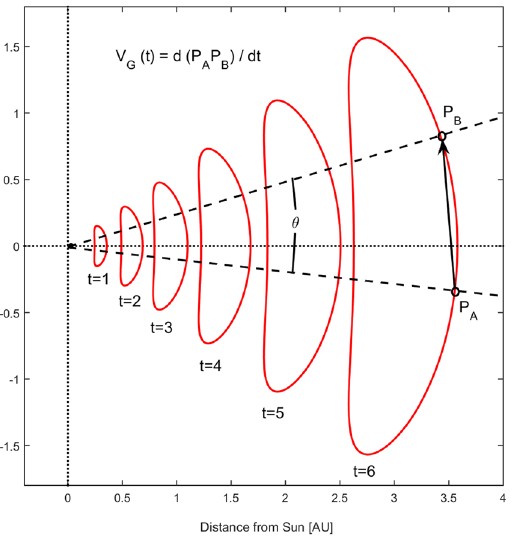
Figure 1. An analytical model for the cross-sectional area of a CME as it propagates anti-sunward. Snapshots are shown at successive times. The plane is perpendicular direction of propagation (e.g., the ecliptic or RN planes in heliocentric radial-tangential-normal, RTN, coordinates). Points P A and P B on the leading edge of the CME subtend an angle θ at the centre of the Sun. Due to radial propagation in spherical geometry, P A and P B separate with time, leading to the geometric speed V G